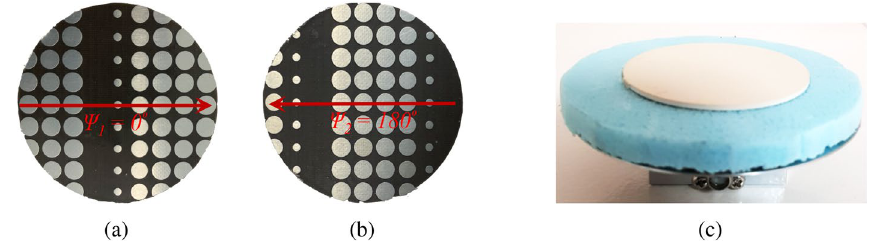
Figure 14. Fabricated prototype of ( a ) Lower phase-gradient metasurface, ( b ) Upper phase-gradient metasurface, ( c ) Single-layer uniform-superstrate resonant cavity antenna. The diameter of both metasurfaces and RCA superstrate is 3 (cid:31) 0